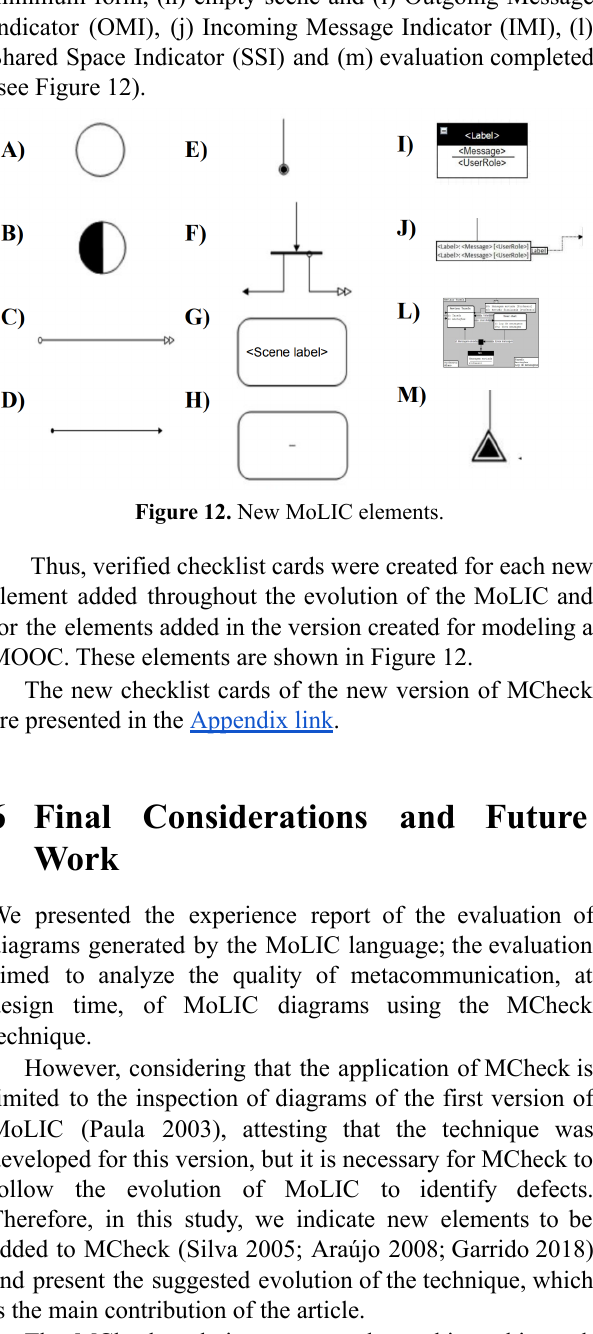
Figure 11. Number of defects per check item.